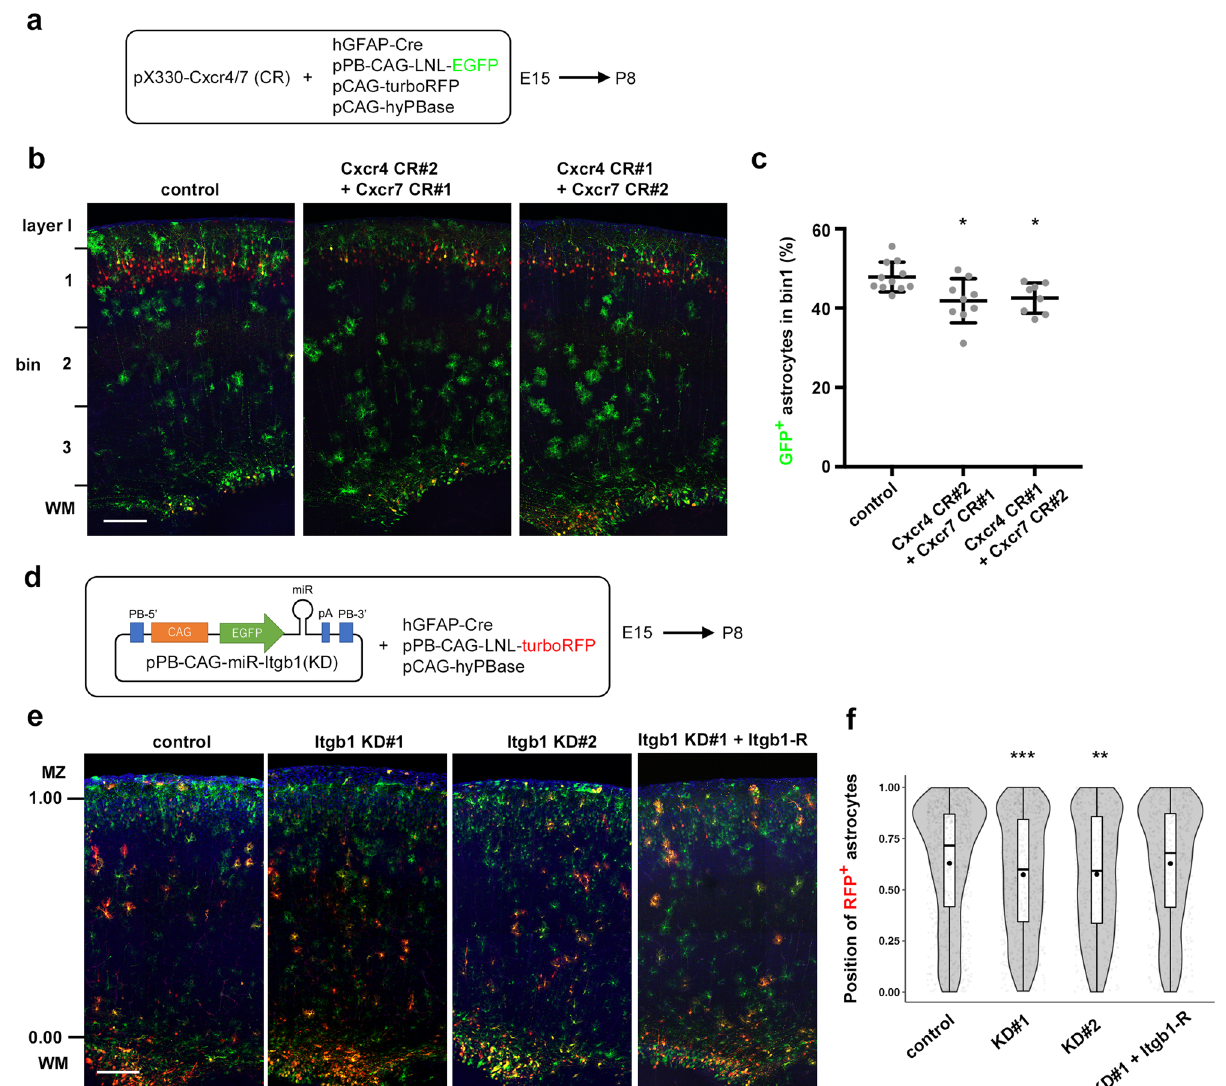
Fig. 8| The fi naldistributionofastrocytesisaffectedbyfunctionalblockingof the Cxcr4/7-Integrin β 1 signaling axis. a – c CRISPR vectors for Cxcr4 and 7 dis- rupted the positioning of astrocytes in the CP at P8. a E15 brains were electro- porated with the indicated combinations of CRISPR vectors for Cxcr4 and 7, and were fi xedatP8. b Resulting brains.Astrocytes and neurons werelabeled withGFP and RFP, respectively. c The astrocytes electroporated with CRISPR-vectors for Cxcr4 and Cxcr7 were reduced in bin 1 (horizontal bars represent mean±SD, two- sided Dunnett ’ s multiple comparison test, control (11 brains) vs. Cxcr4 CR#2+ Cxcr7 CR#1 (9 brains), P =0.0108; control vs. Cxcr4 CR#1+Cxcr7 CR#2 (8 brains), P =0.0298 in bin 1). d – f Knockdown of Itgb1 also disrupted the distribution